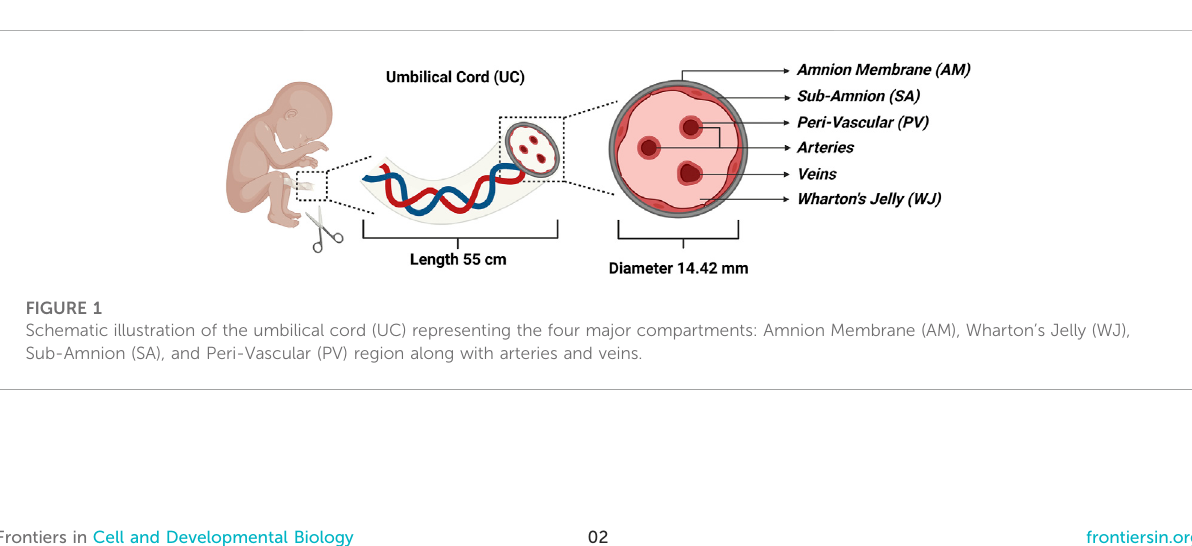
Frontiers in Cell and Developmental